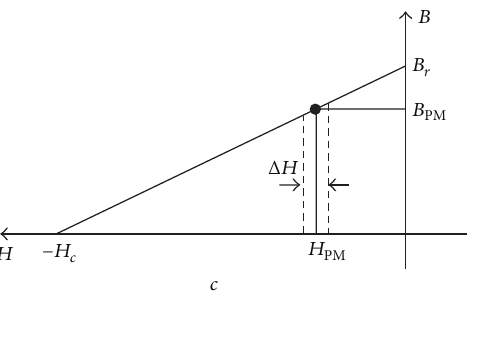
Figure 2: Permanent-magnet demagnetization curve.